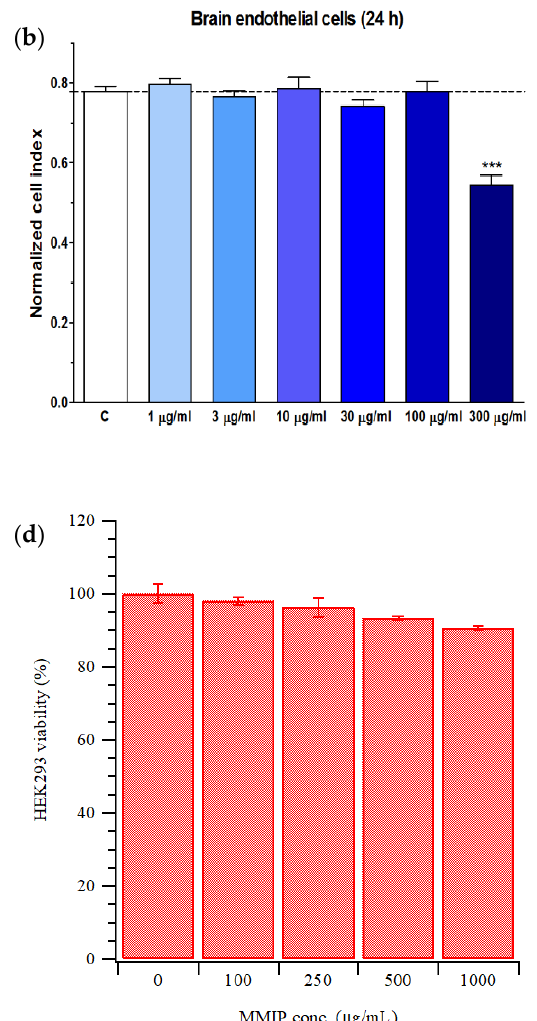
Figure 4. ( a ) Adsorption of P5, P6, and P7 on the P5 MMIPs and MNIPs. ( b ) Adsorption of P5, P6,